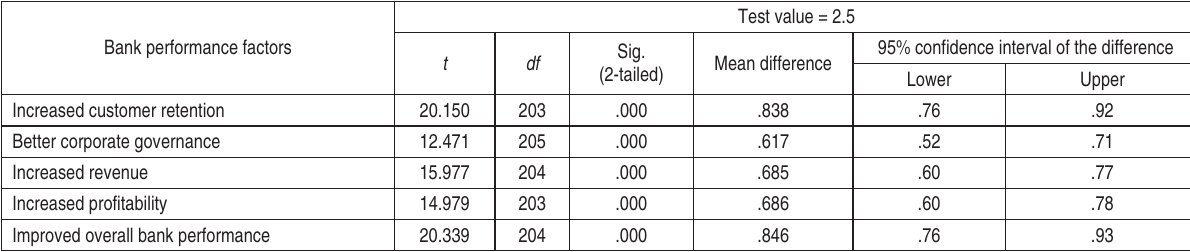
Table 6. One sample t-test – servant leadership on bank performance